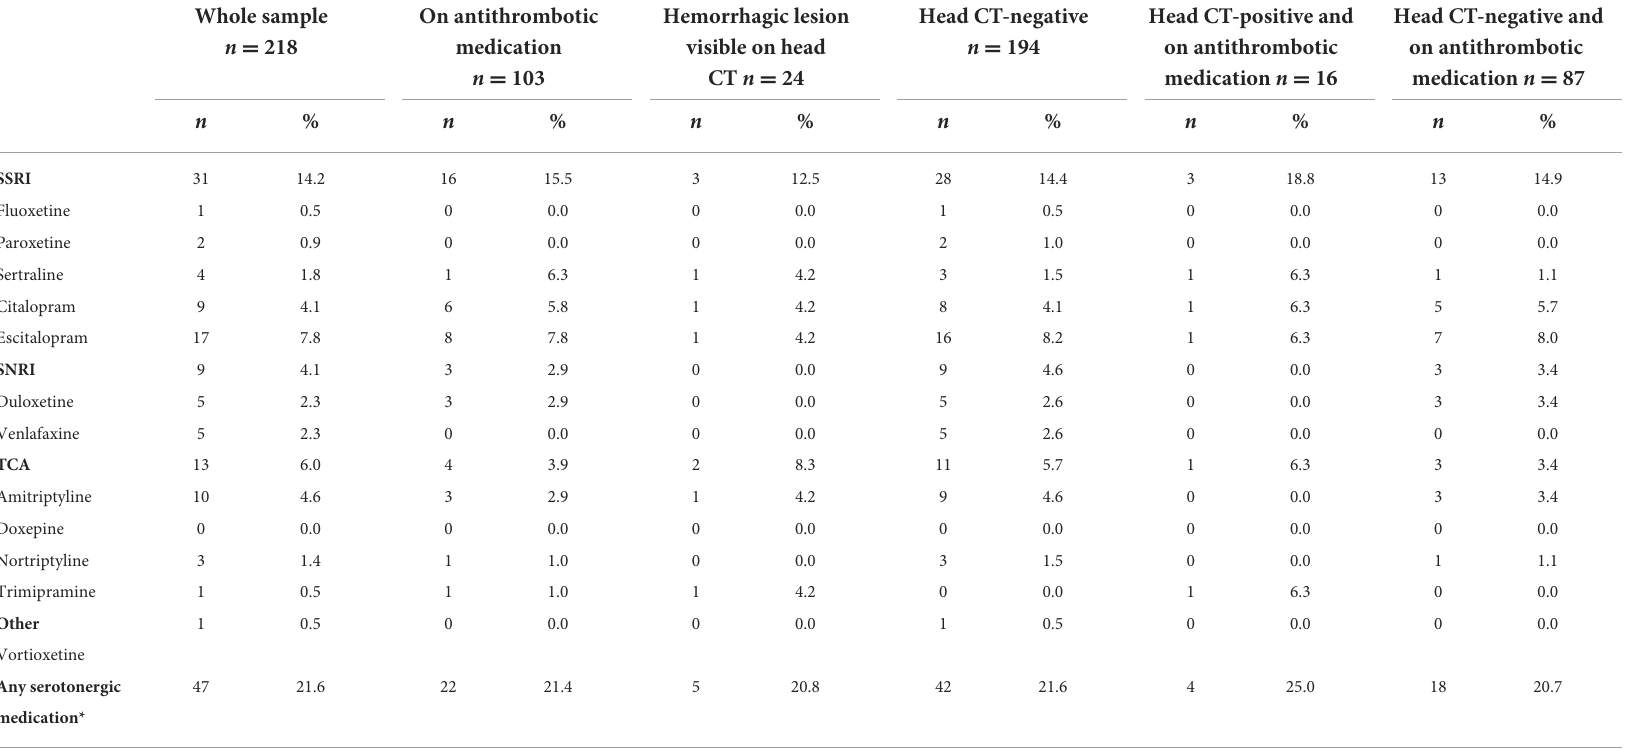
TABLE 3 Use of serotonergic antidepressants stratified by the head CT finding and antithrombotic medication